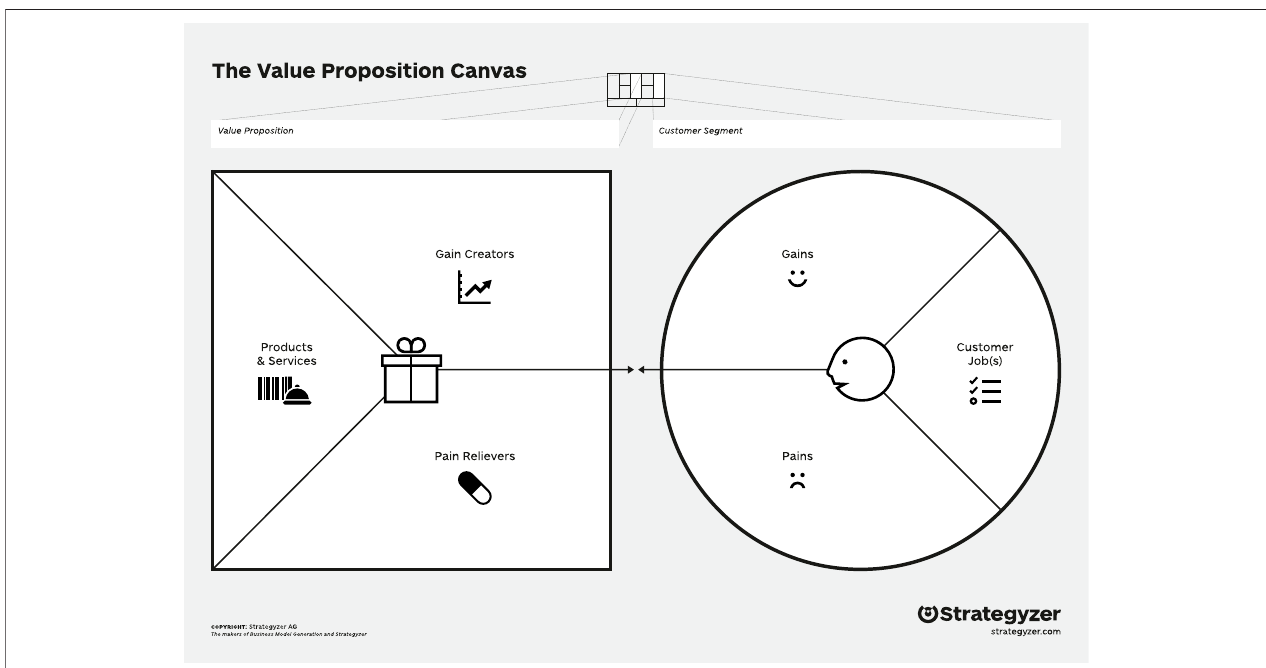
FIGURE 1 | Value proposition canvas and its relation to the business model canvas (based on Osterwalder et al. (2014), Strategyzer.com, and with copyright by Strategyzer AG).